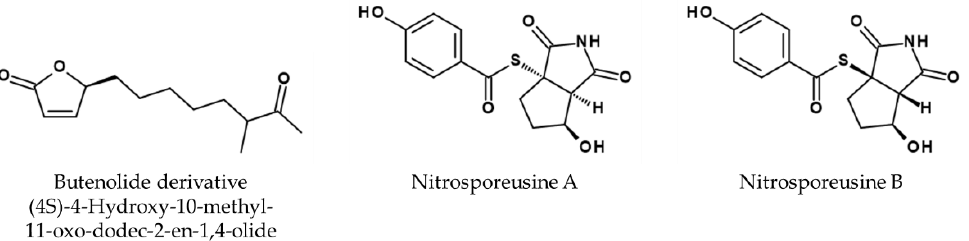
Figure 9. Structure of butenolide derivative ((4 S )-4-Hydroxy-10-methyl-11-oxo-dodec-2-en-1,4- olide) [151] and nitrosporeusine A and B